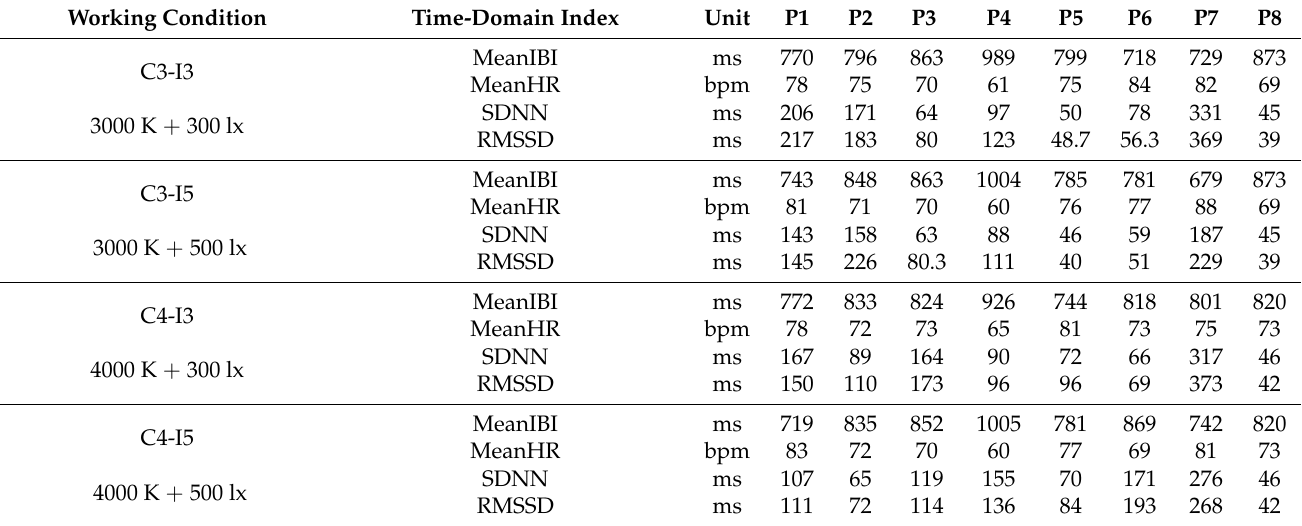
Table 7. HRV time-domain